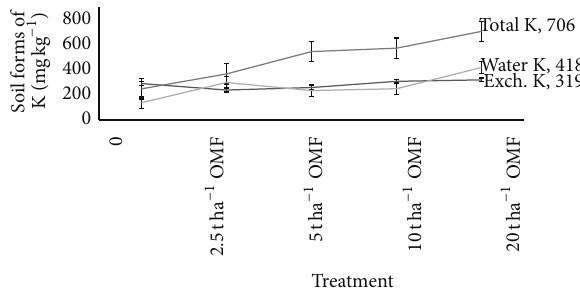
Figure 3: Effect of organomineral fertilizer on soil forms of K. Total K Lsd (0.05) = 10.05, water K = 10.66, and exch. K =